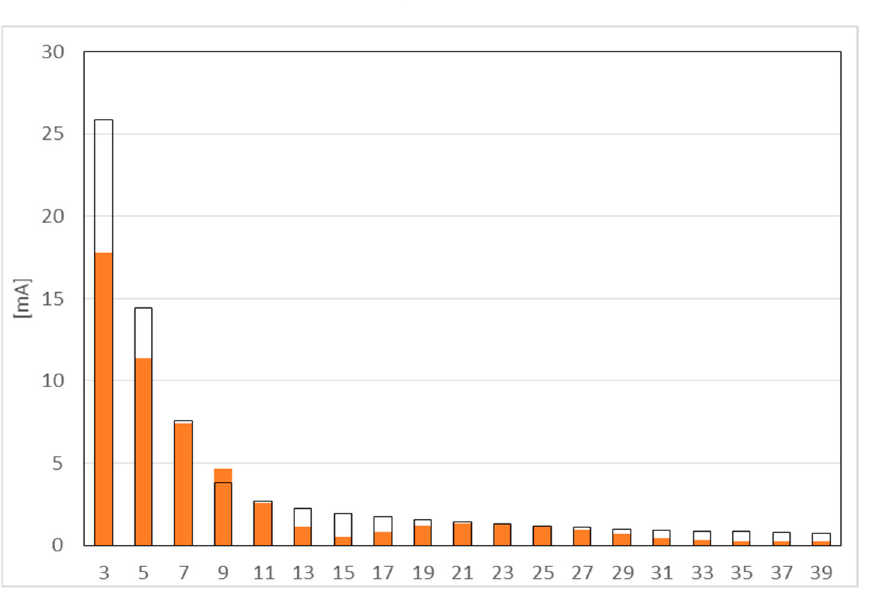
Figure 4. Harmonic emissions test.